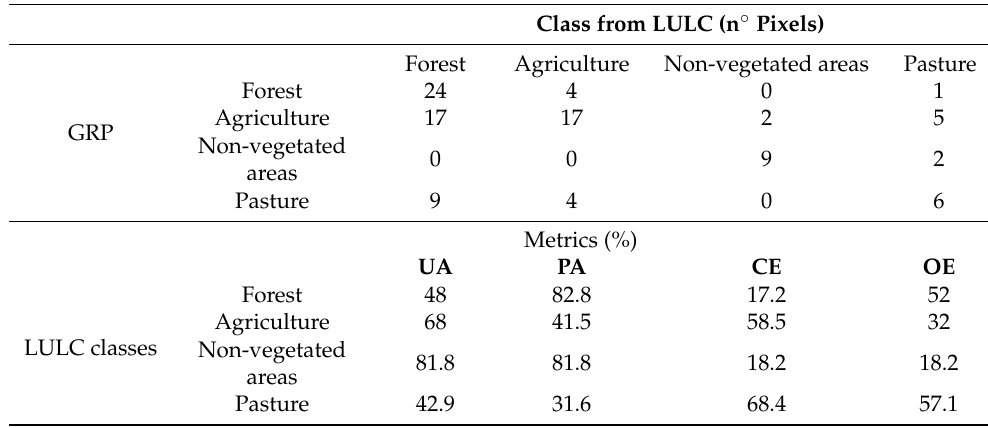
Table 7. Confusion matrix of LULC. UA = User Class Accuracy, PA = Producer Class Accuracy, CE = Commission Error, OE = Omission